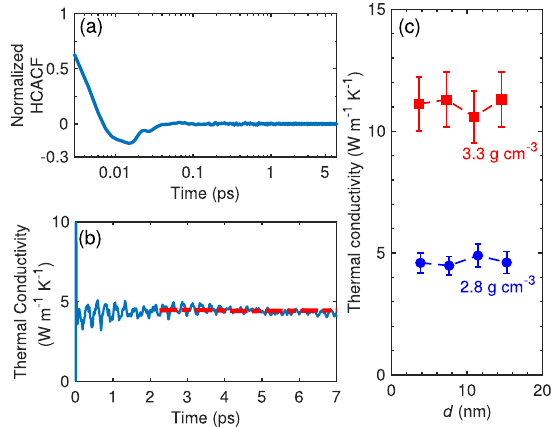
Fig. 6 Green-Kubo approach to predict thermal conductivity of amorphous carbon. Normalized heat current autocorrelation func- tion (HCACF) versus time for our amorphous carbon structure with a mass density of 3.02 g cm − 3 described by the Tersoff potential. b Thermal conductivity is determined from the integration of the HCACF and a converged value is obtained by averaging from 2 to 7 ps integration time. c Thermal conductivity as a function of computational domain length, d , for our amorphous carbon structures with 2.8 g cm − 3 and 3.3 g cm − 3 as described by the modi fi ed Tersoff potential. The error bars represent uncertainties calculated based on results from three independent